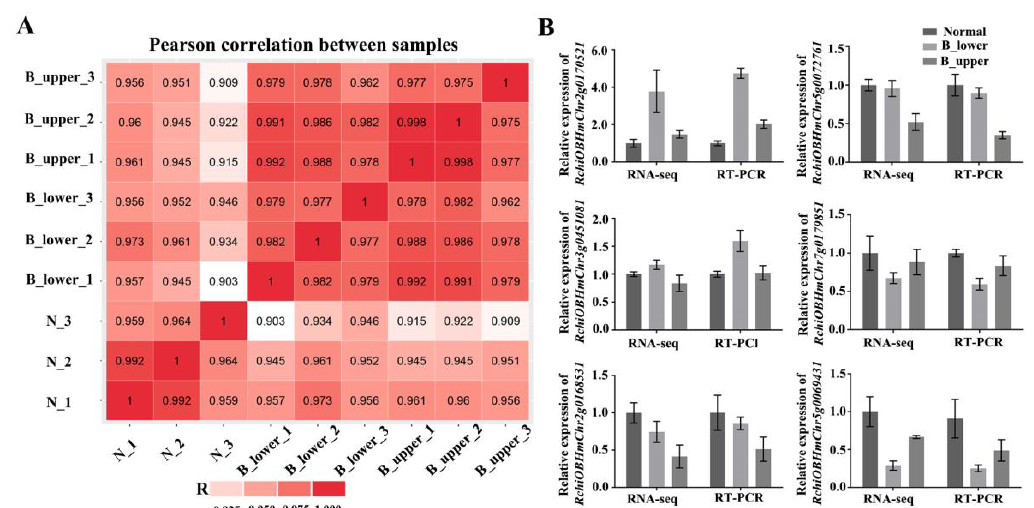
Figure 3. Validation of transcriptome data. ( A ) Pearson correlation between nine samples. ( B ) Relative expression of six selected genes ( RchiOBHmChr3g0451081 , auxin-response protein; RchiOBHmChr5g0069431 , calcium/proton exchanger; RchiOBHmChr2g0170521 , gibberellin-regulated protein; RchiOBHmChr7g0179851 , ARR5-like; RchiOBHmChr5g0072761 , expansion; RchiOBHmChr2g0168531 , zinc finger) determined by qRT-PCR for validation of RNA-seq results. RhUbi2 was used as an internal control. Error bars represent SD. Three biological replicates were performed.